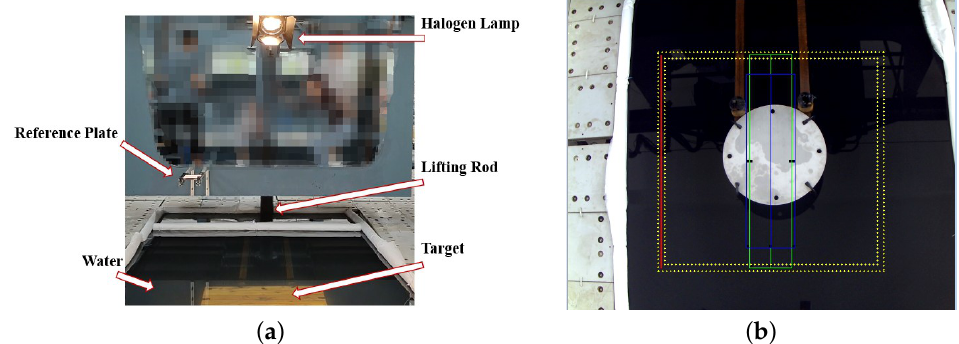
Figure 6. The spectra collection configurations. ( a ) The experimental site. Note that a halogen lamp is used for brightening, but the data in this paper did not use this. ( b ) The field of view of the spectral imager.